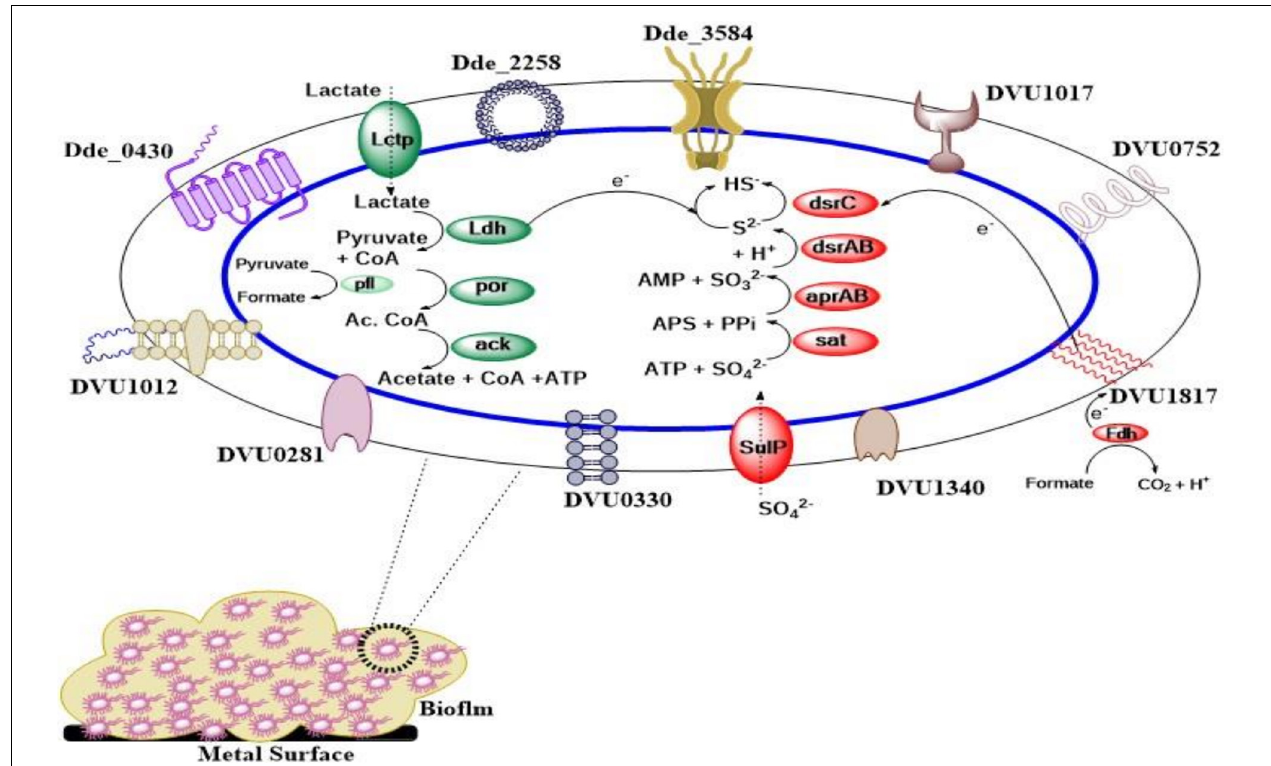
FIGURE 1 | Pictorial representation of biofilm forming and lactate oxidation/sulfate reduction proteins. (Cellular location of all the biofilm formation genes is shown in Supplementary Table 1 . Lctp , lactate permease; Ldh , lactate dehydrogenase; por , pyruvate-ferredoxin oxidoreductase; ack , acetate kinase; pfl , pyruvate formate lyase; SulP , sulfate permease; sat , sulfate adenylyltransferase; aprAB , adenosine-5 (cid:48) -phosphosulfate (APS) reductase; dsrAB , dissimilatory sulfate reductase; dsrC , dissimilatory sulfite reductase ( Desulfoviridin ), gamma subunit; Fdh , formate